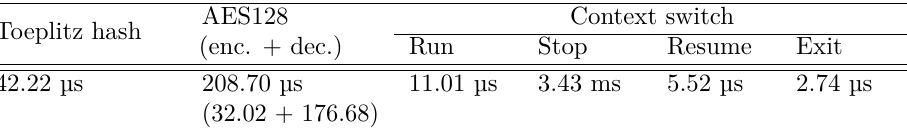
Table 7: Comparison of execution time (HiFive